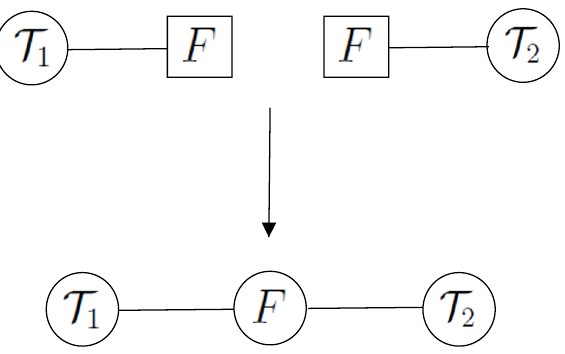
Figure 9 . Gluing two theories T 1 and T 2 by identifying and gauging the common flavor symmetry F